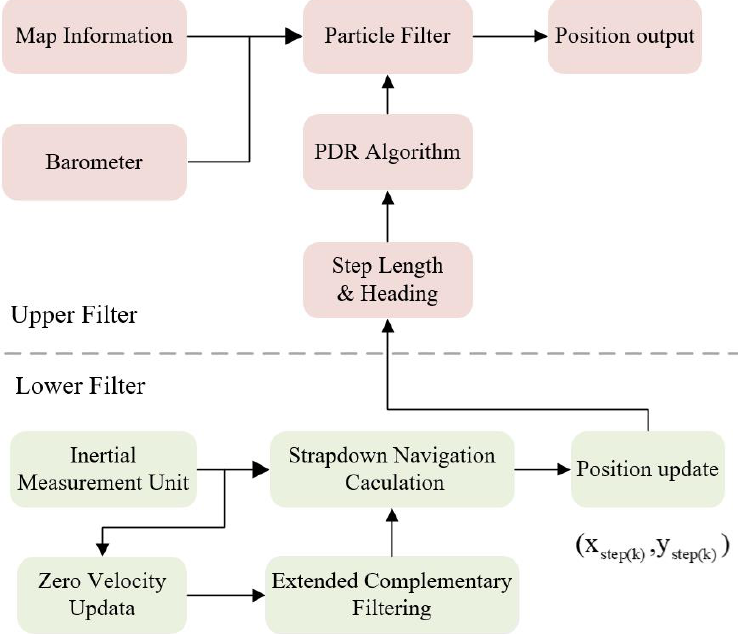
Figure 1. The overall frame diagram of the cascade filtering